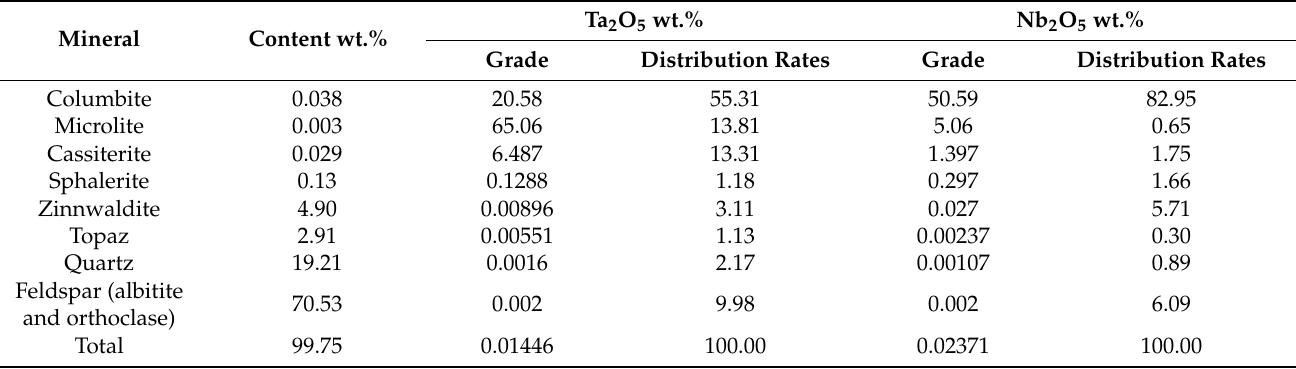
Figure 4. Microscopic characteristics of the ore. (From this perspective, albite is the main gangue mineral bearing conspicuous lamellar bi ‐ crystals; quartz particles are coarse and semi ‐ automorphic; the particle size distribution of muscovite is uneven, and the interference color is bright). Table 3. Modes of occurrence of tantalum and niobium, and their